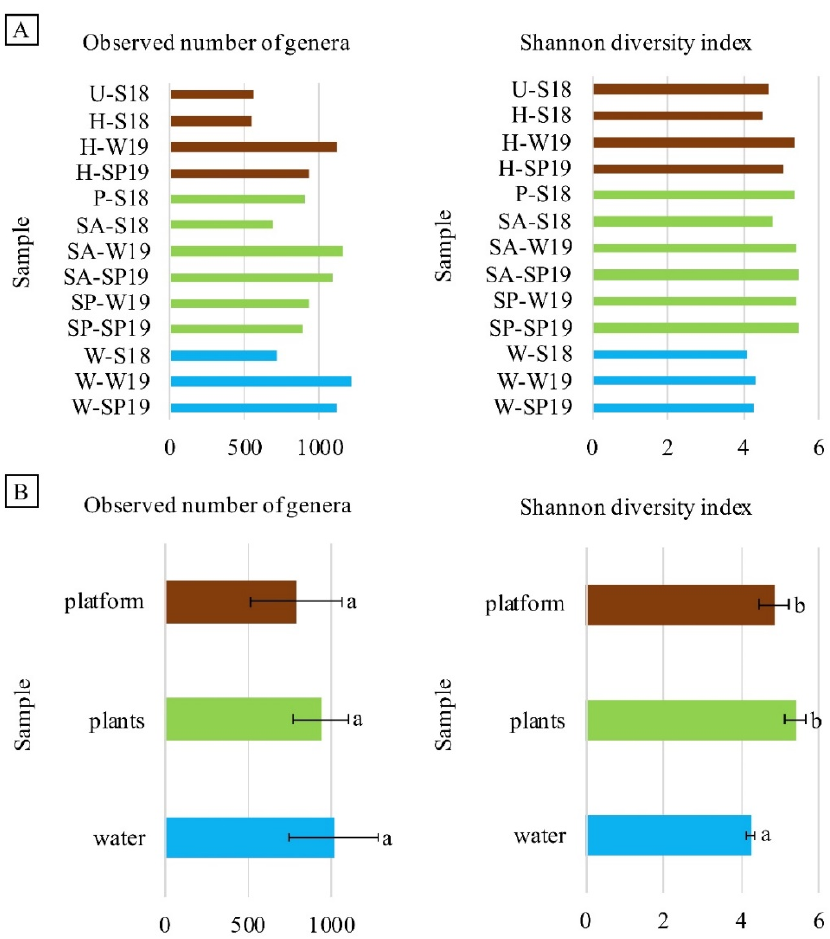
Figure 6. Alpha-diversity metrics (Shannon diversity index and richness–observed number of genera): ( A ) across all the individual samples; ( B ) comparison between type of samples. Brown bars represent the biofouling samples from the floating platform (H = non-planted holes and U = Under surface), green bars represent the biofilm samples from the planting media (SP = Spartina maritima ; SA = Sarcocornia perennis ; and P = Phragmites australis ) and blue bars represent the water samples (W); S18 = Summer of 2018; W19 = Winter of 2019 and SP19 = Spring of 2019. The di ff erent letters placed on the bars show the statistically significant di ff erences ( p < 0.05) between the type of samples.